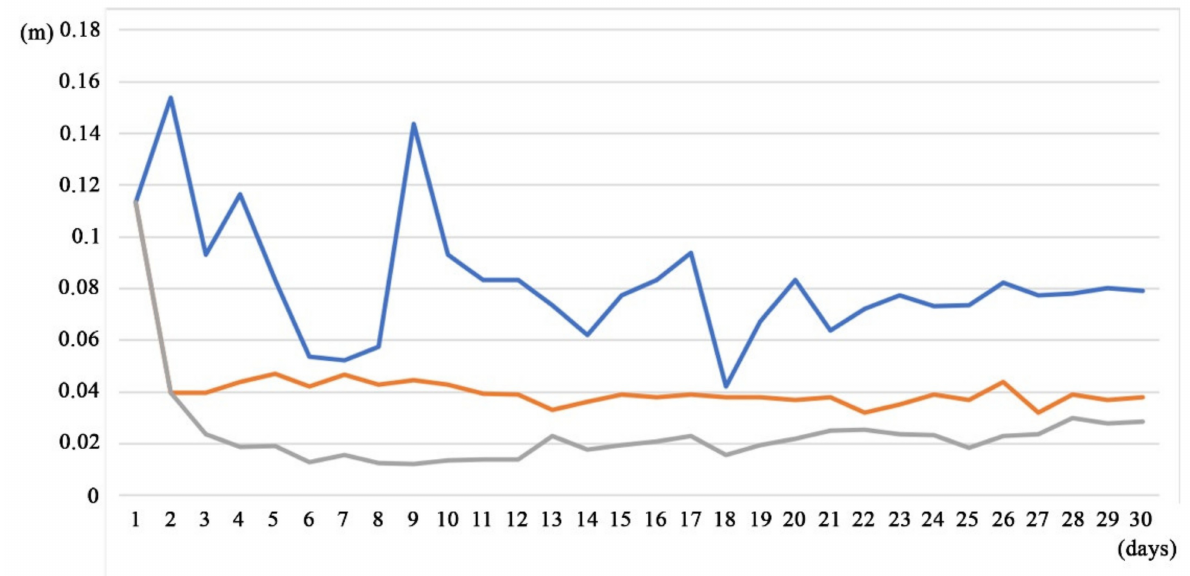
Figure 2. Root mean square deviation of SLA analysis for 3 model runs. The blue line refers to the control model deviation; the orange line refers to the EnOI model deviation; the grey line refers to the GKF model